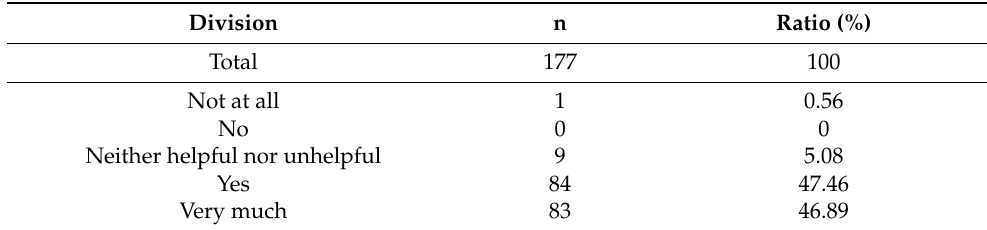
Table 4. Was the workshop helpful in expanding your understanding of the major? Division